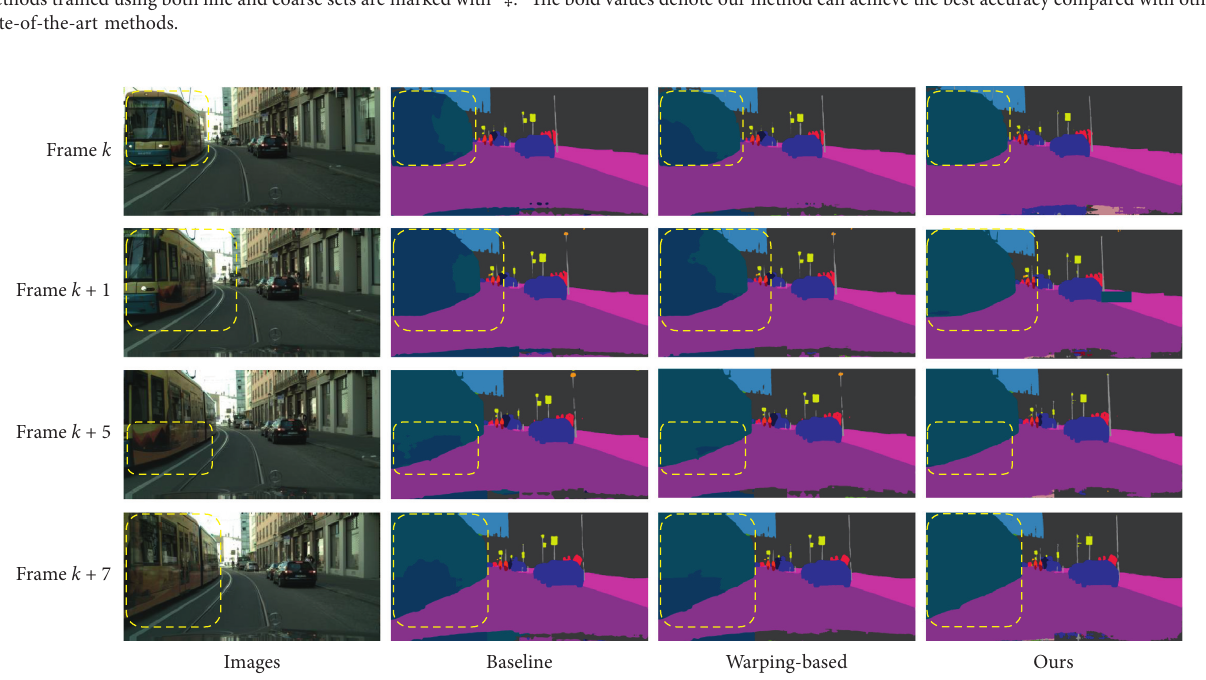
Figure 4: Qualitative results of consecutive frames on the Cityscapes dataset. Baseline methods: training and inferring on single frames.